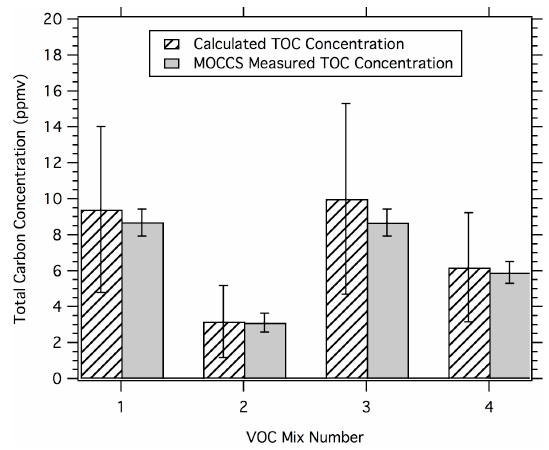
Fig. 5. The results of a total carbon analysis of 4 gas phase VOC standards. The contents of each mixture are detailed in Table 1. An uncertainty of 20% was assumed for each component in the laboratory-generated VOC standards.